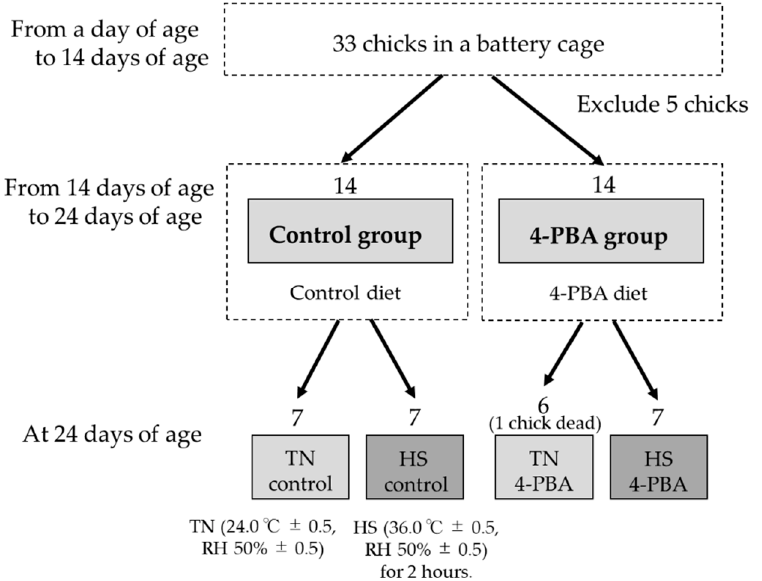
Figure 1. Animal experimental procedure. Twenty-eight male chicks were randomly allocated to two treatments ( n = 14 for each treatment group) in a completely randomized design at 14 days of age. The chicks of the 4-PBA group were switched to the diet containing 4-PBA and fed for 10 days. At 24 days of age, the chicks were separated into 4 groups such that the mean weights of the groups were the same. Then, HS groups were exposed to HS (36.0 ± 0.5 °C, relative humidity 50.0 ± 5.0%)